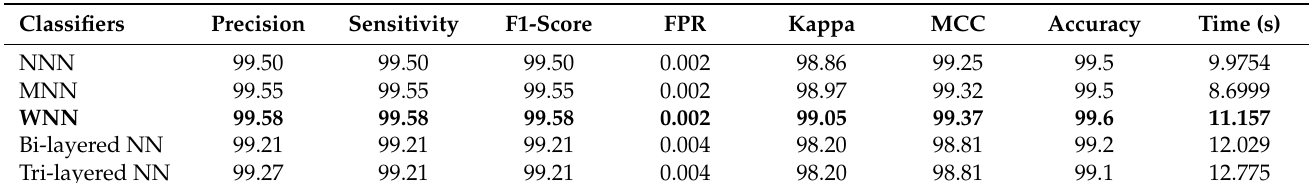
Figure 6. Confusion matrix of MNN for proposed fusion method on Chest X-ray dataset.